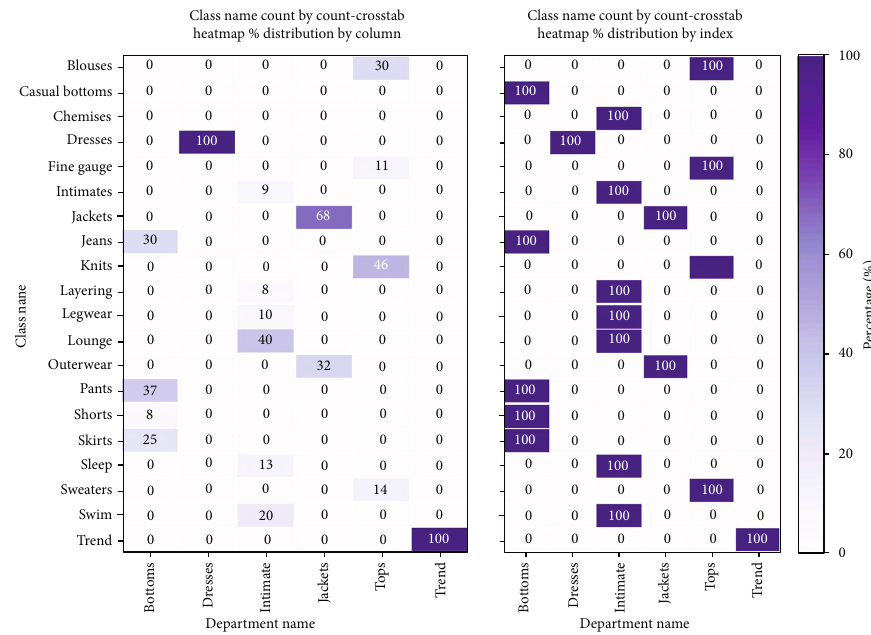
Figure 10: Dress supremacy between types of clothing (class name by division name). Class name count by department name-crosstab heatmap overall count distribution